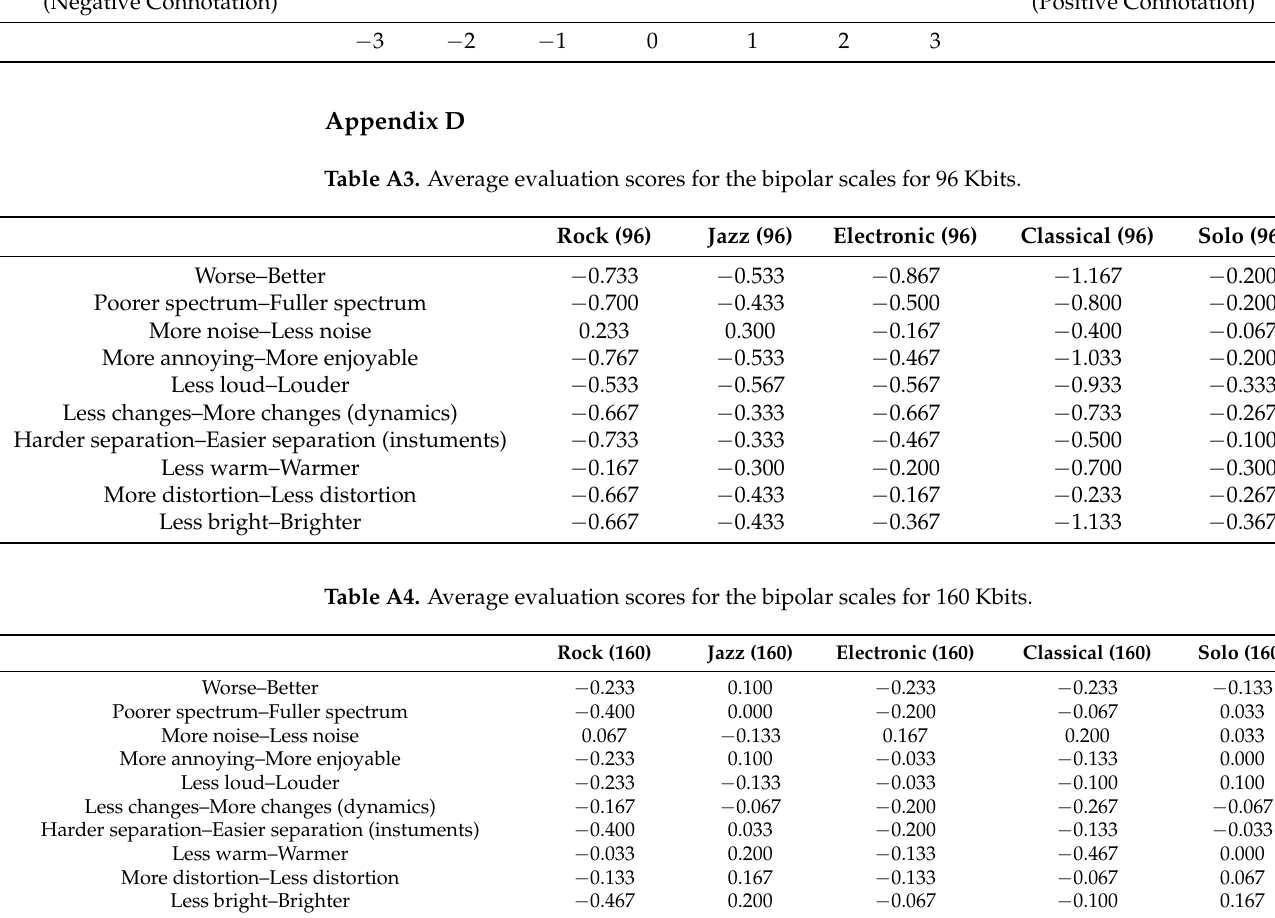
Table A4. Average evaluation scores for the bipolar scales for 160 Kbits.